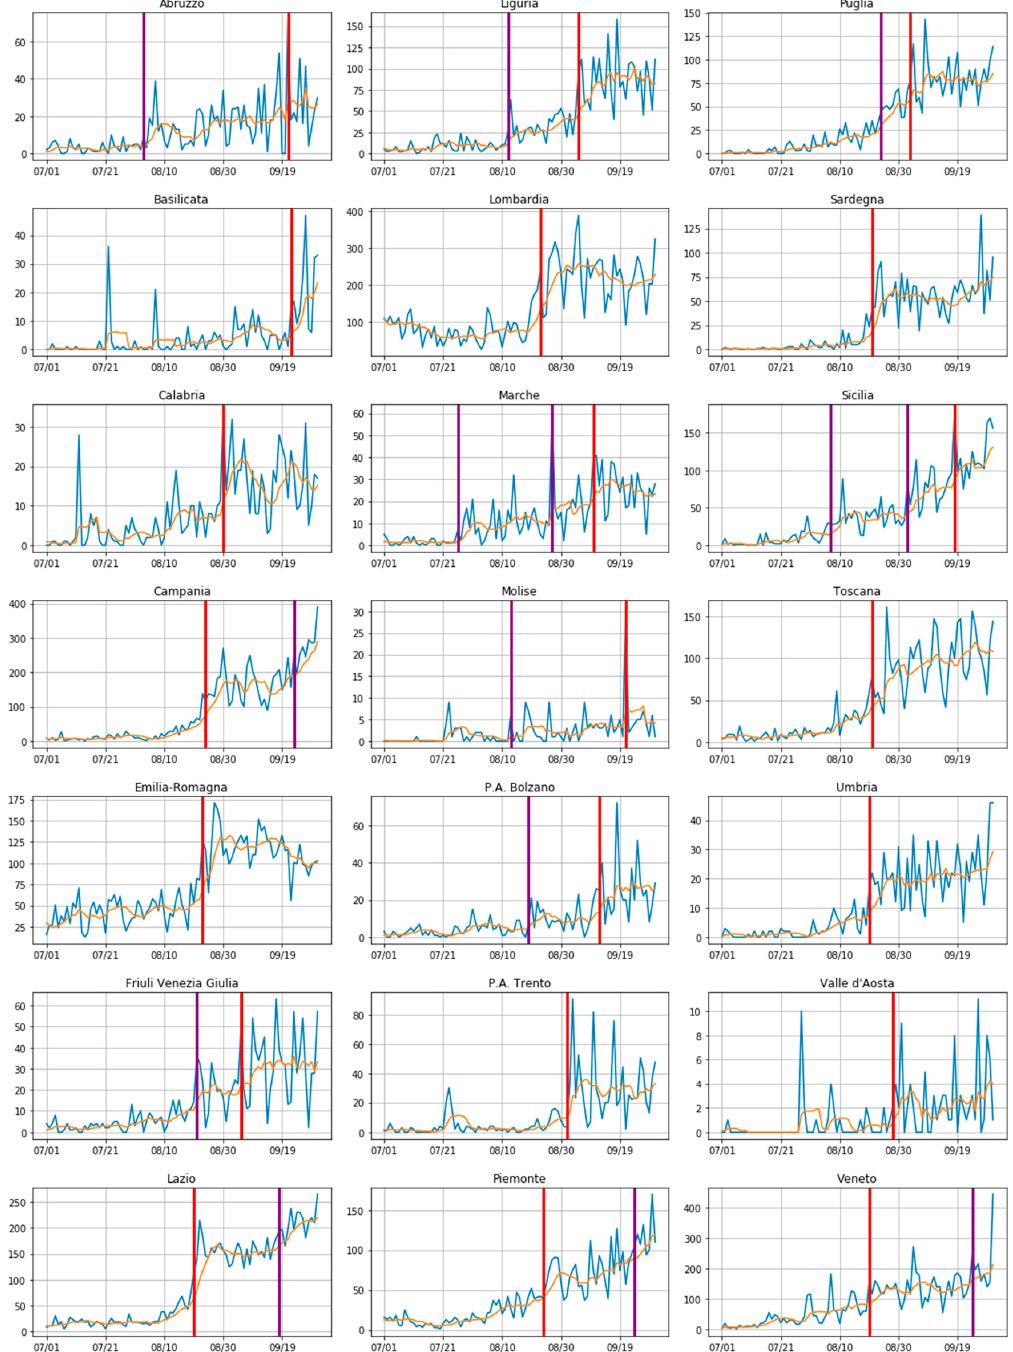
Figure 4. Change points (red lines) found by the change point detection method described in Section 2.2.1. In purple are all the change points detected with a variant of the method. The daily infections curve is depicted in blue, while the correspondent seven-day moving average is in orange. Period of observation: 1 July - 30 September, for each of the 21 Italian regions.